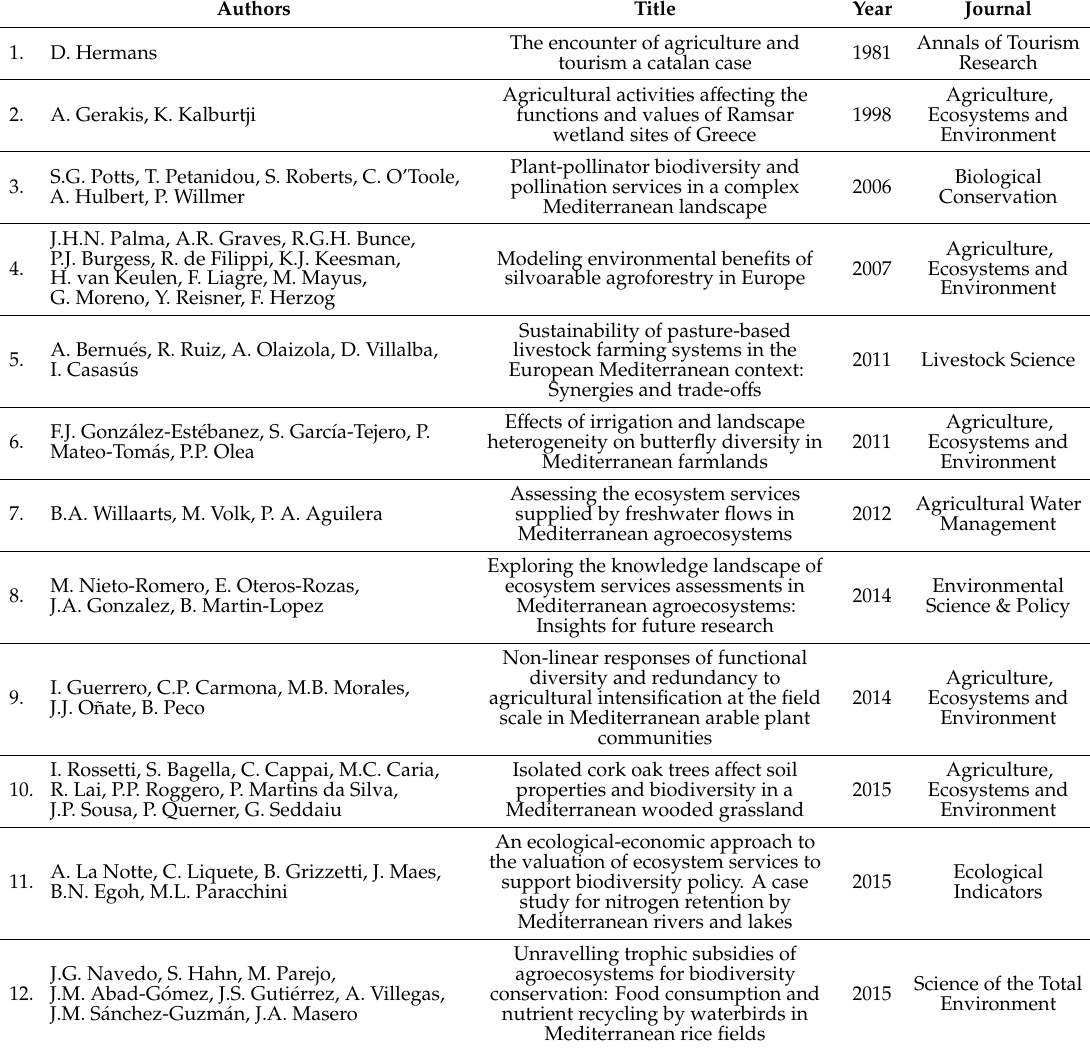
Table A1. List of articles included in this review sorted in chronological